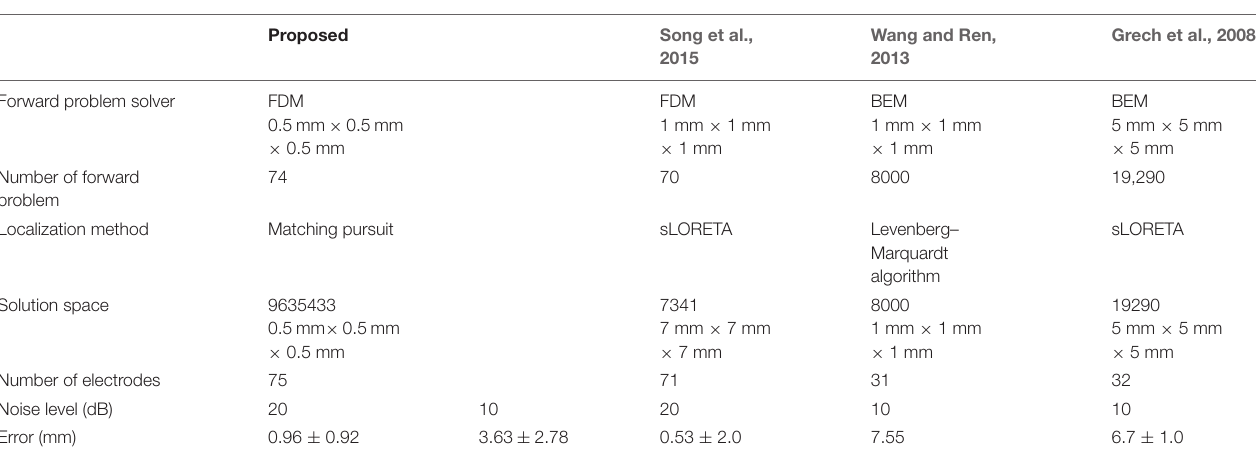
TABLE 7 | Localization performance and specifications of related